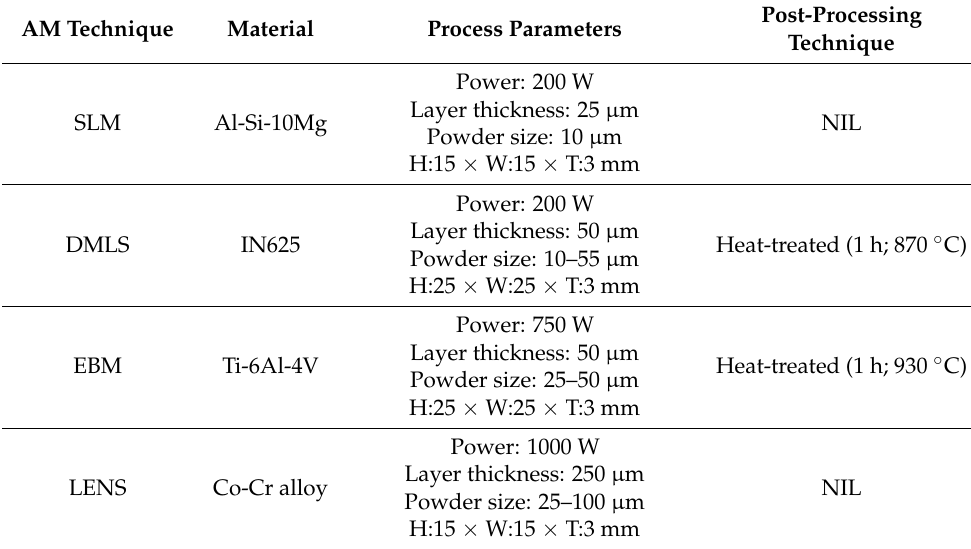
Table 1. Summary of manufacturing